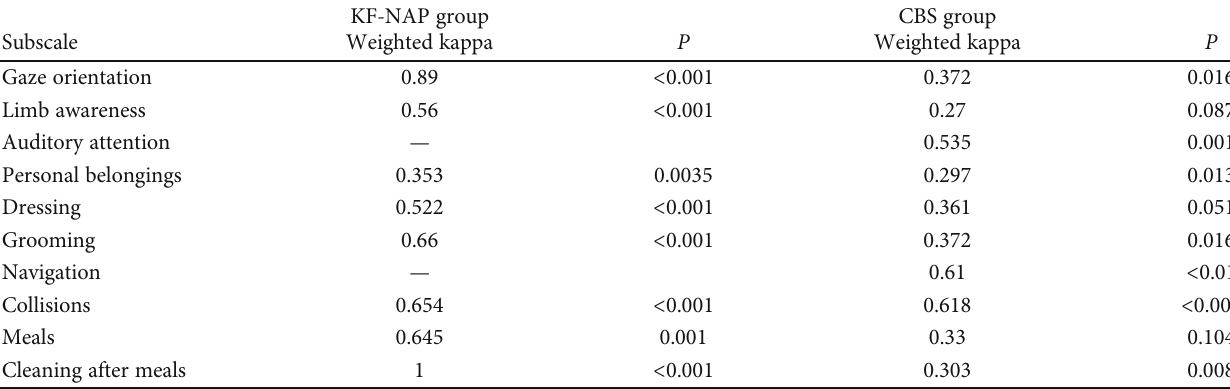
Table 3: Interrater reliability of each subscale of KF-NAP and